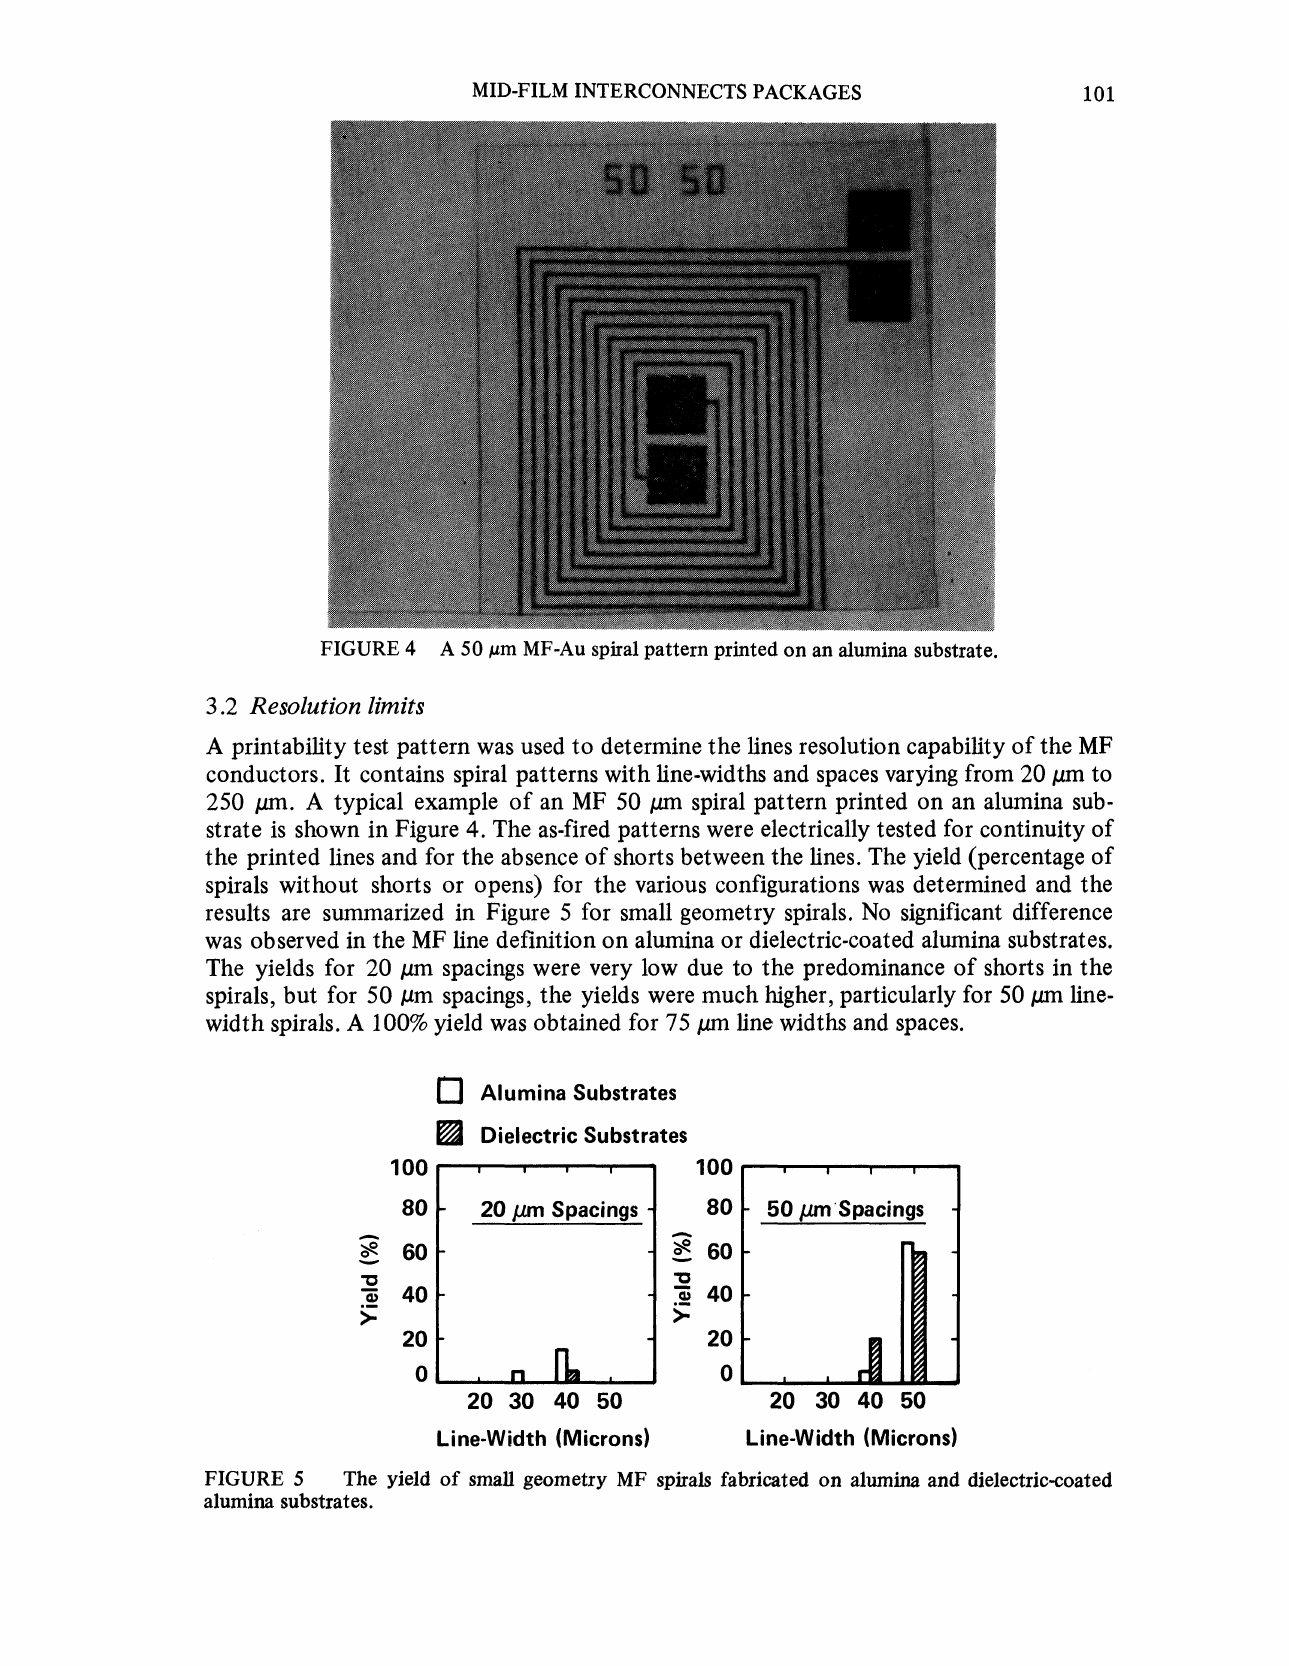
The yield of small geometry MF spirals fabricated on alumina and dielectric-coated alumina